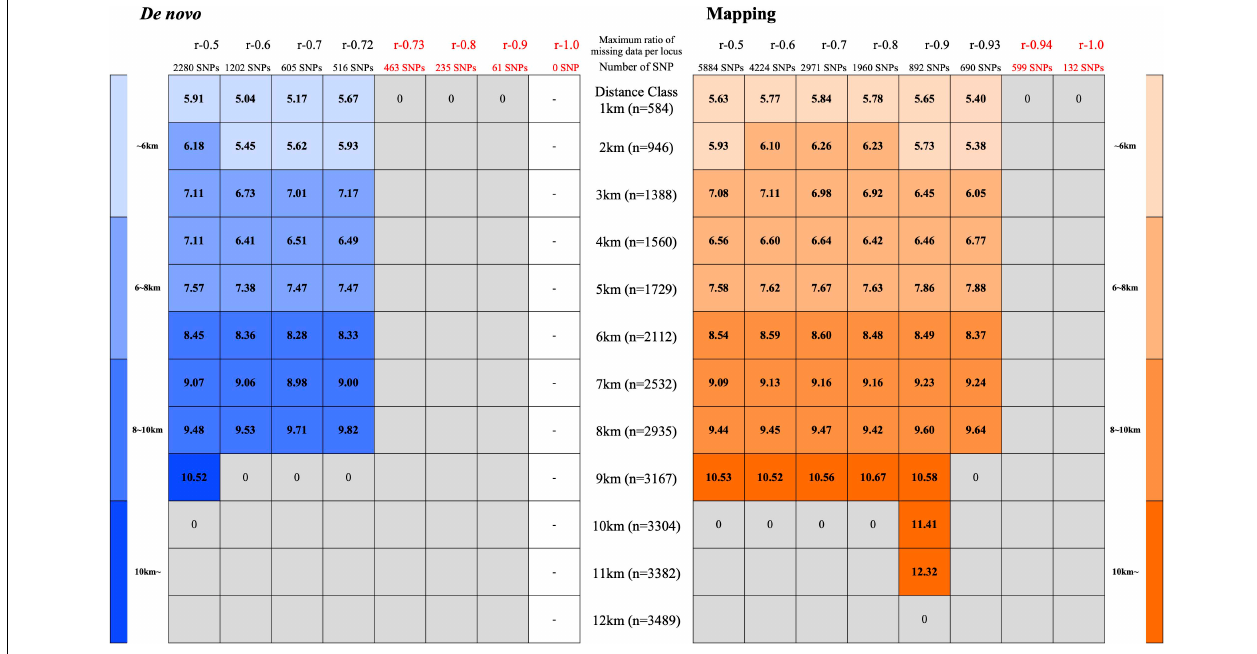
Frontiers in Marine Science |